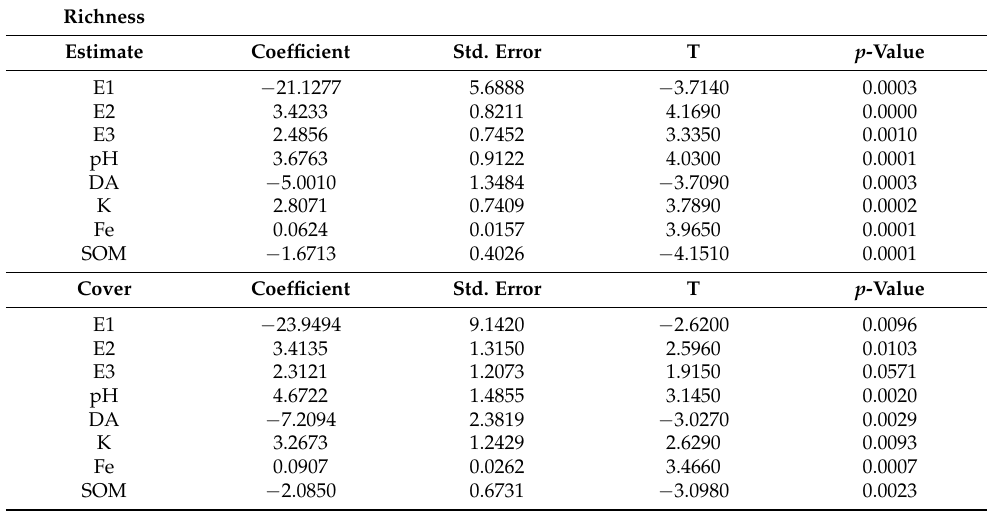
Table 3. Generalized linear models (GLM) to explore effects in richness and cover of biological soil crust related to elevation and soil